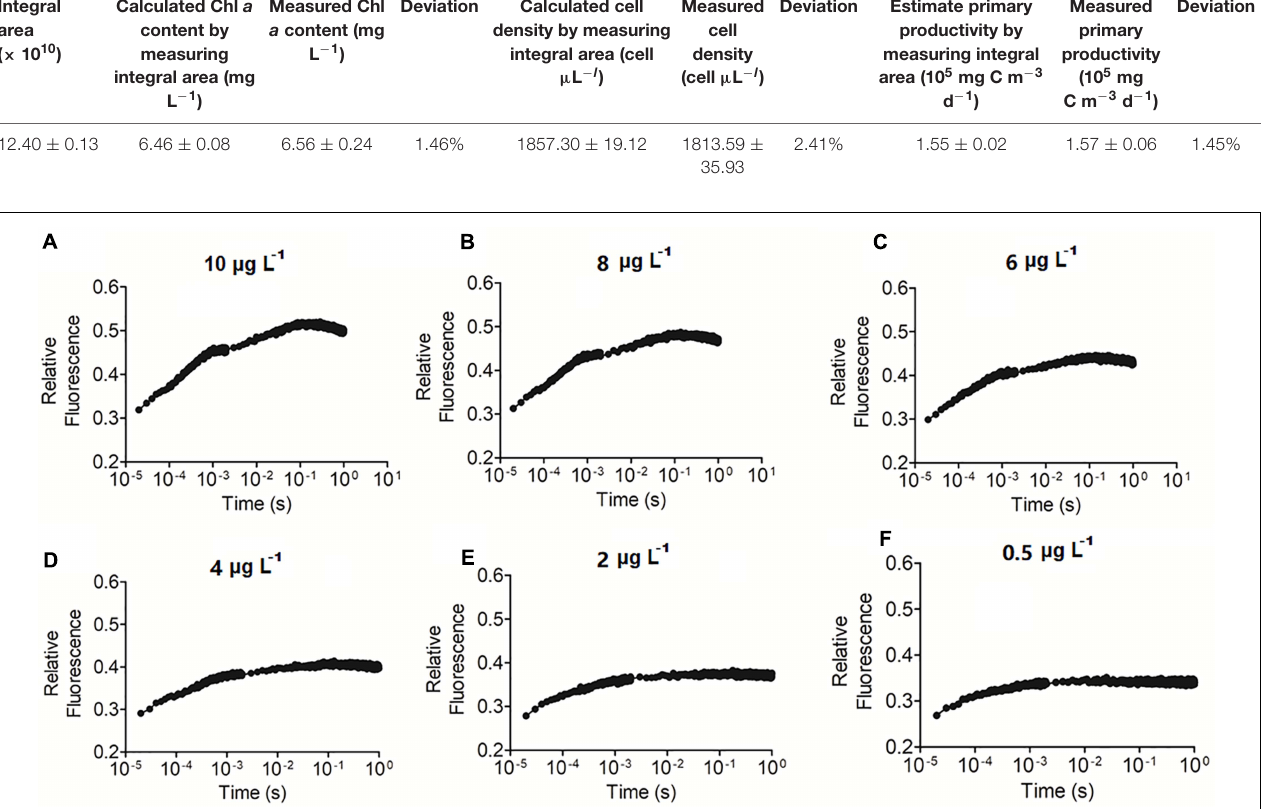
FIGURE 4 | Precision analysis of the OJIP curve method for detecting Chl a . (A–F) represents the OJIP curve of water samples with 0.5–10 µ g L - 1 Chl a content,